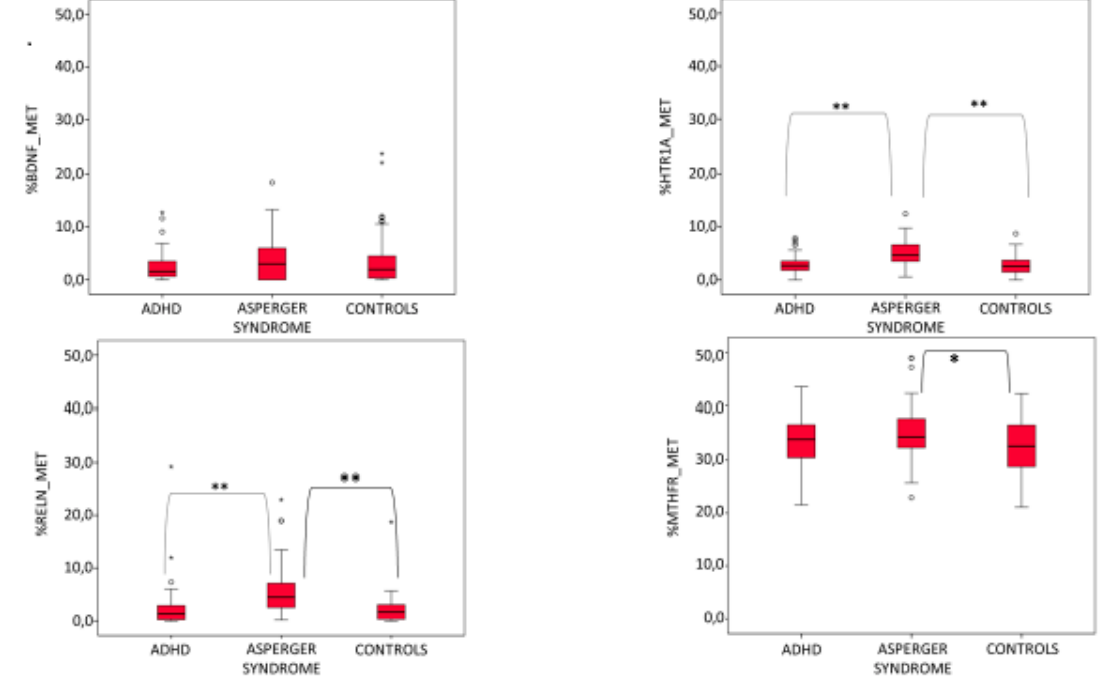
Figure 1. Percentage of methylation for the BDNF, HTR1A, RELN and MTHFR genes in ADHD, AS